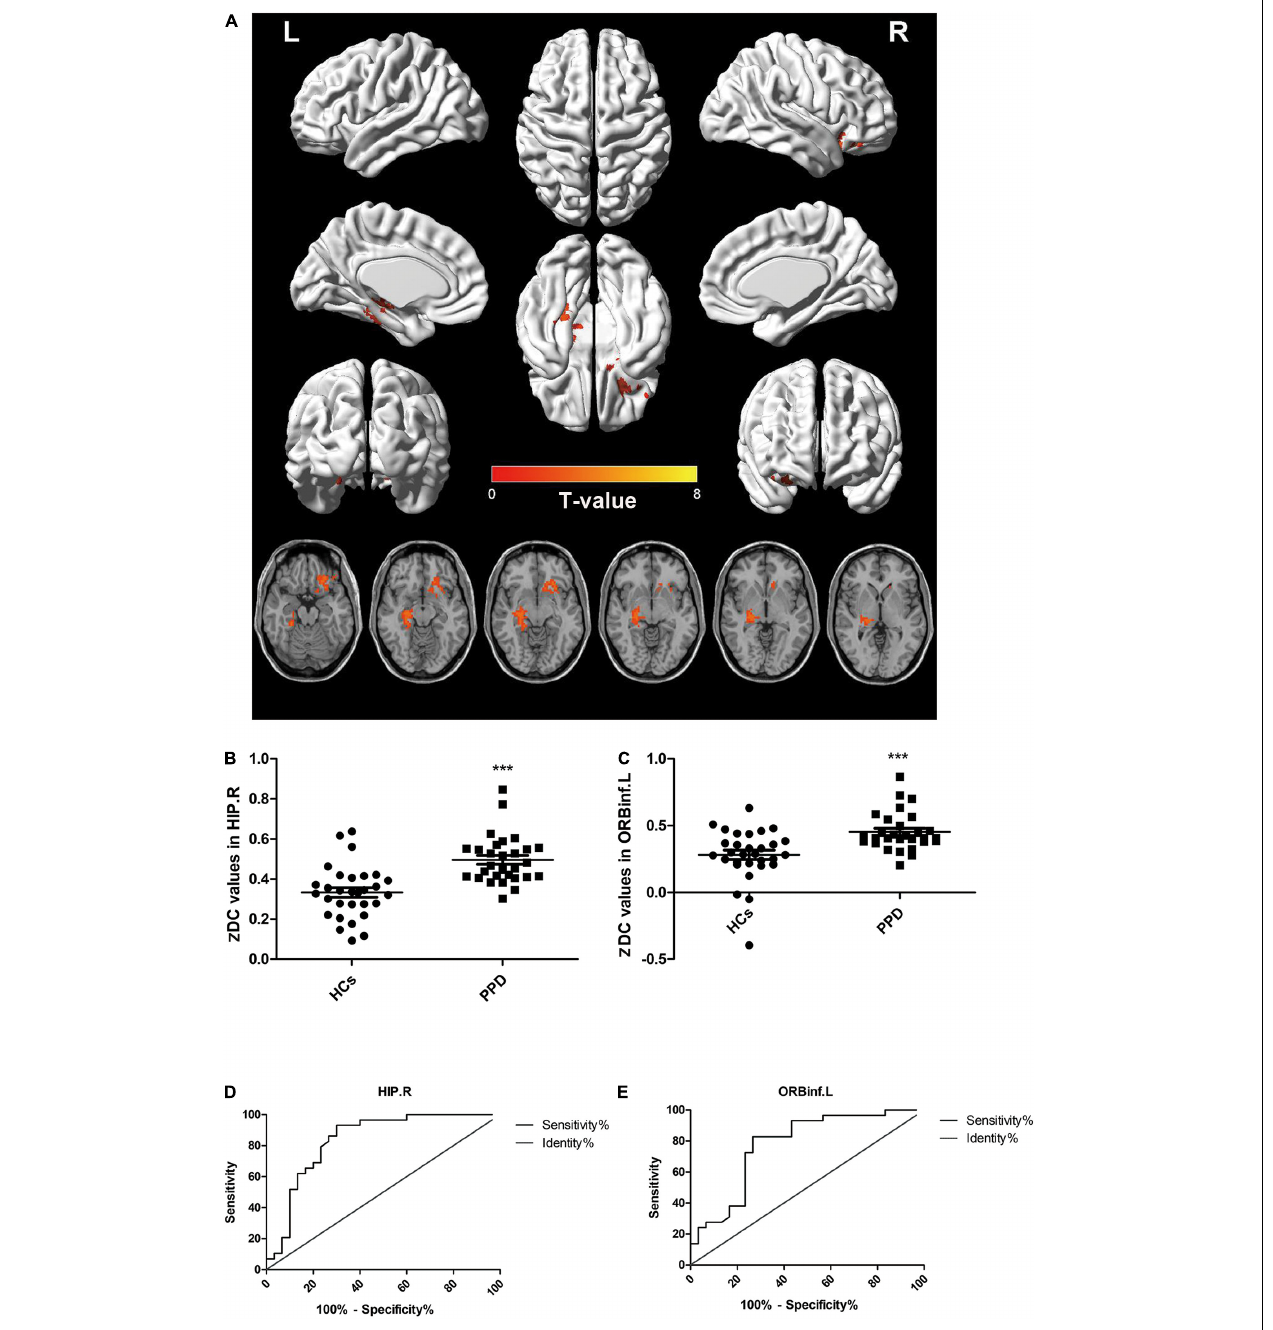
FIGURE 1 | Comparisons of degree centrality between patients with postpartum depression (PPD) and healthy controls (HCs). (A) Brain regions with different degree centrality (DC) values between groups: HIP.R and ORBinf.L. (B,C) The distribution and comparison of DC values of brain regions in the PPD and HCs. (D,E) The ROC curve evaluates the diagnostic value of the DC value of different brain regions to distinguish patients with PPD from healthy mothers. HIP.R, right hippocampus; ORBinf.L, left inferior frontal orbital